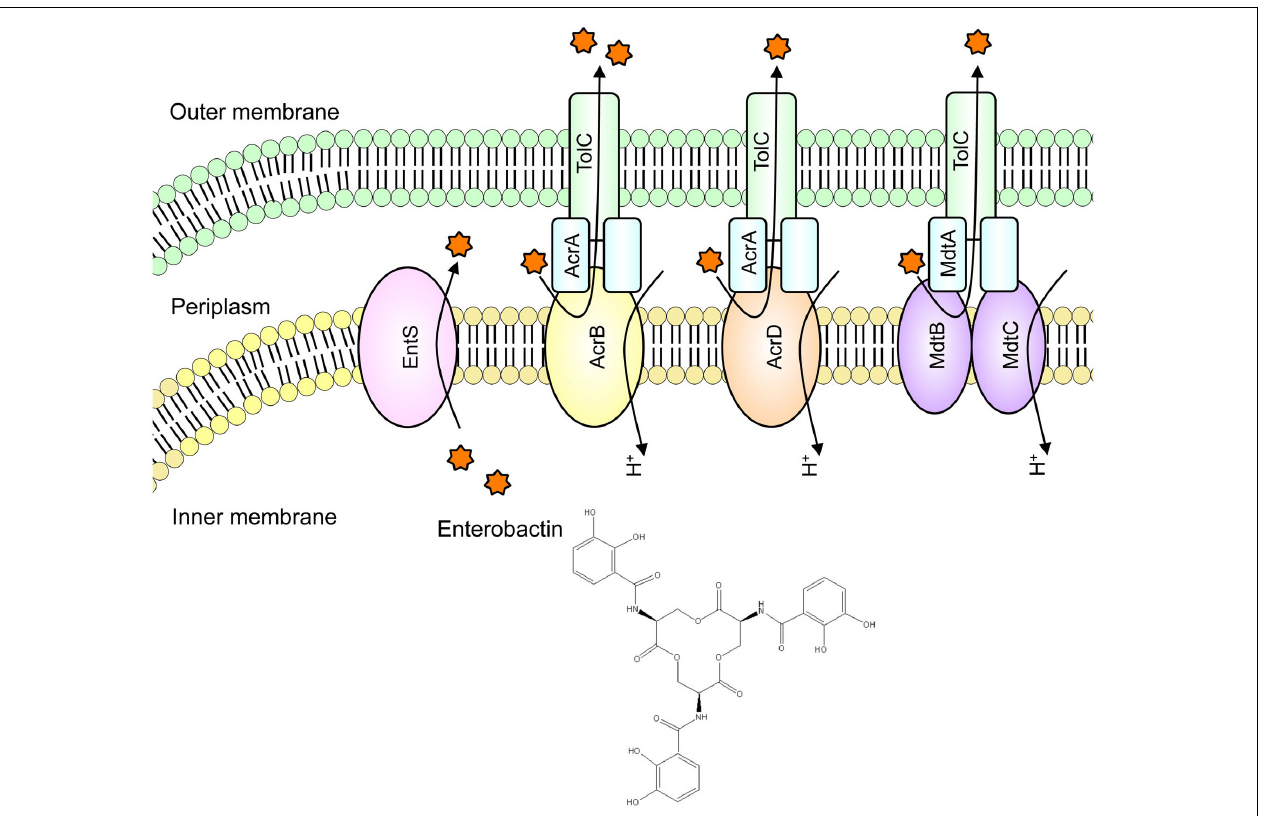
FIGURE 4 | Iron chelator transport via drug efflux systems. We found that in iron-deficient conditions, enterobactin (a siderophore) is extruded out of the cell via drug efflux pumps to acquire iron for the